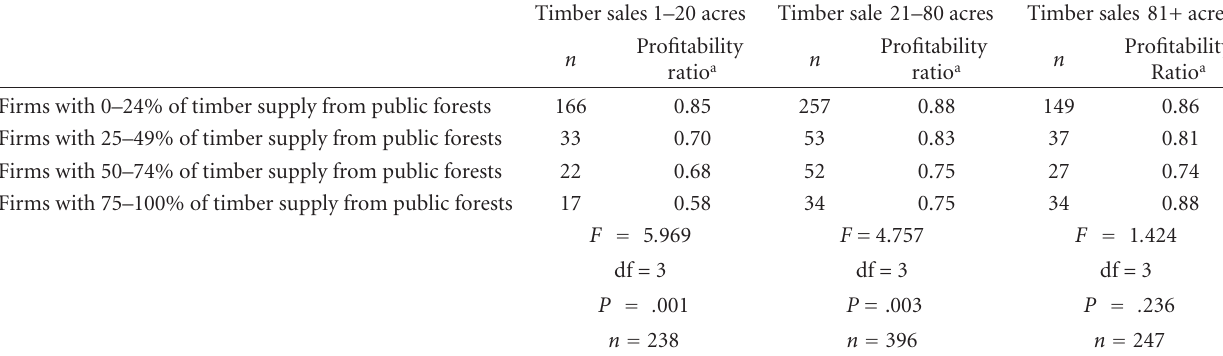
Table 4: Relationship between profitability of timber sales of varying sizes by source of timber supply (public forests).